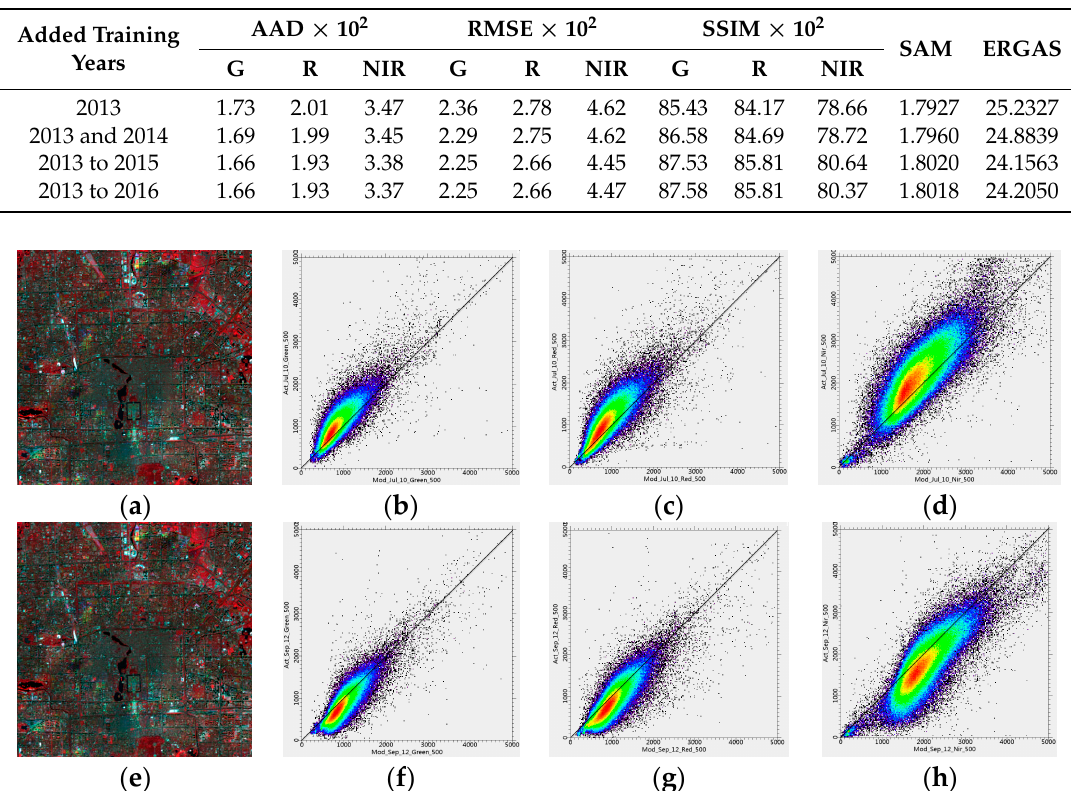
Table 9. Assessment indices from the proposed fusion with the urban data acquired from 2013 to 2016 for modeling reflectance on 10 July 2017.